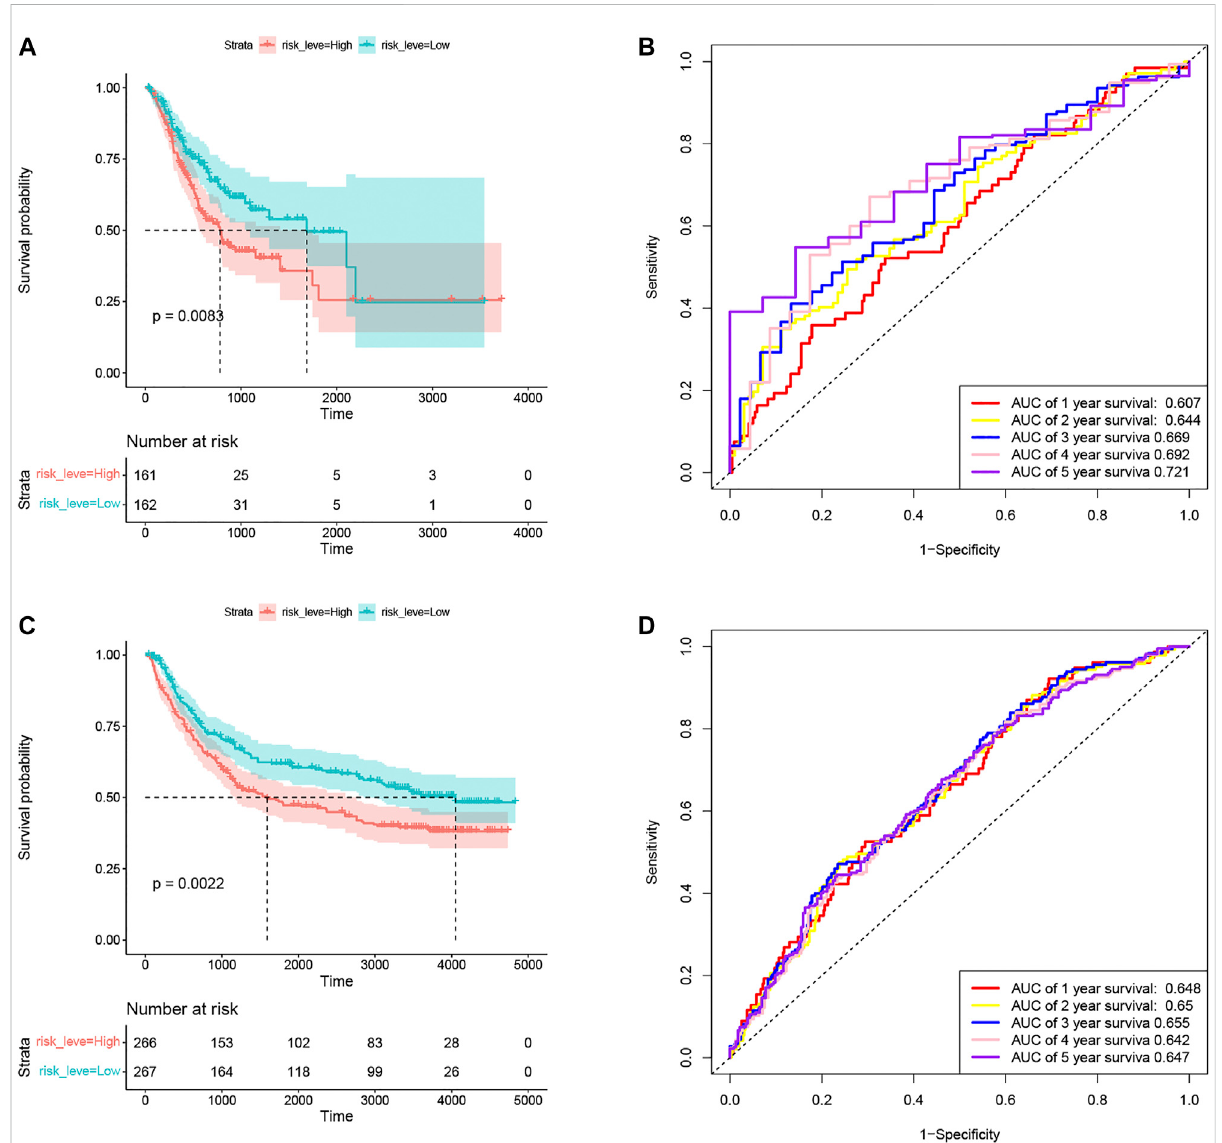
FIGURE 4 EvaluationandvalidationoftheprognosticperformanceofCoag-Scoreintrainingandvalidationsets. (A,C) KMsurvivalcurvesofCoag-Scorein TCGA-STAD and GEO cohort. (B,D) ROC curves of Coag-score in TCGA-STAD and GEO